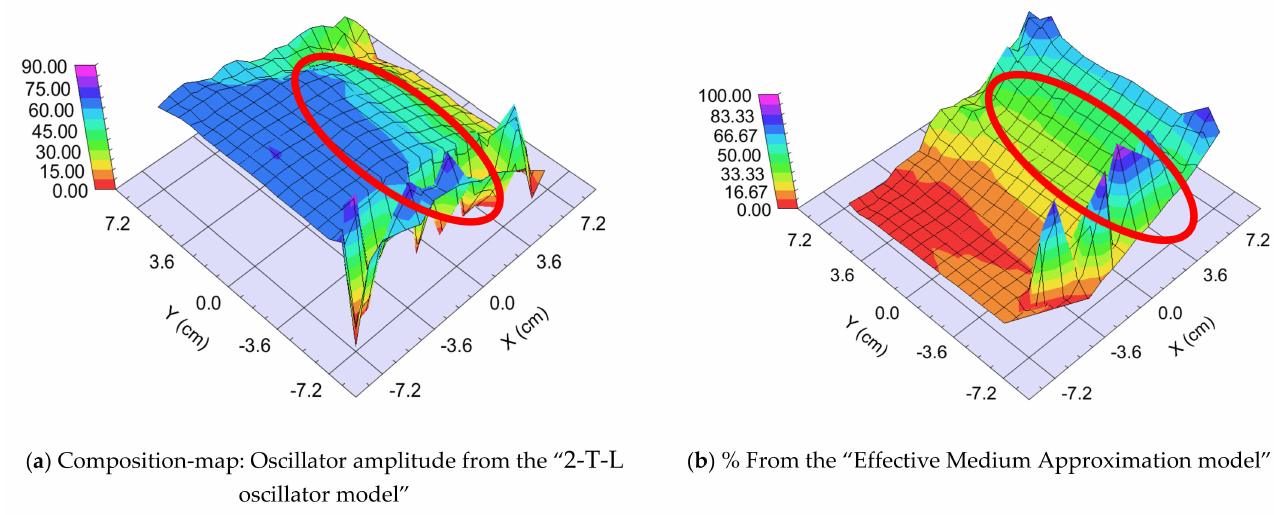
Figure 14. Amplitude-of-T-L (only WO 3 )–map ( a ) and EMA% (MoO 3 )–map ( b ). Red ellipses show the interesting area, where the composition changes the most. We show only one 15 × 15 cm part, all other parts show the same